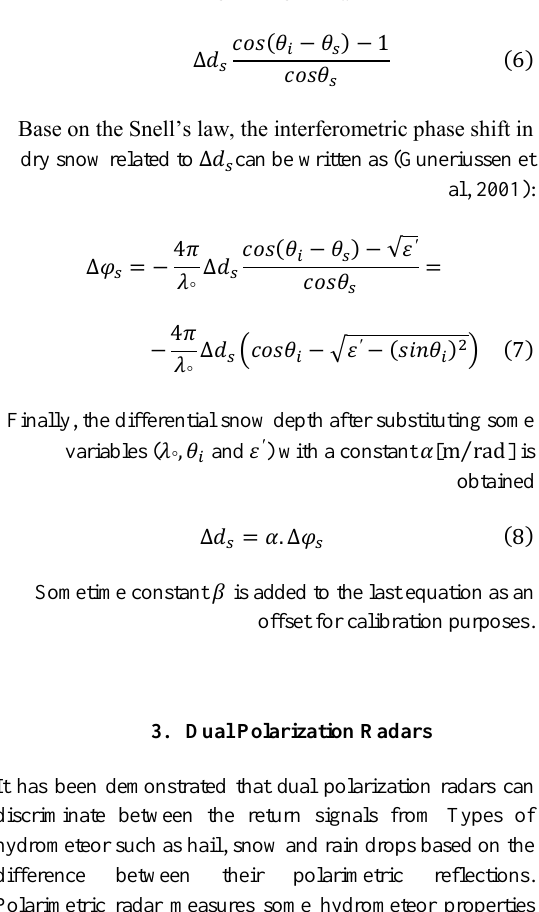
Base on the Snell’s law, the interferometric phase shift in dry snow related to can be written as (Guneriussen et